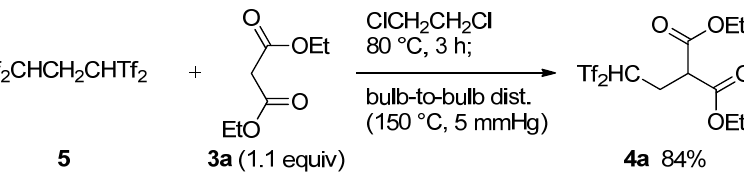
CHCH CHTf ( 5 ) in CDCl at 40 °C 2 2 2 3 CH ( 1 ); triangles, Tf C=CH ( 2 2 2 2 2